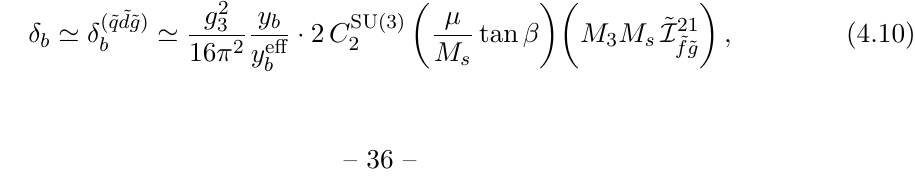
) =y e(cid:11) at the matching scale (cid:3) = M s b b